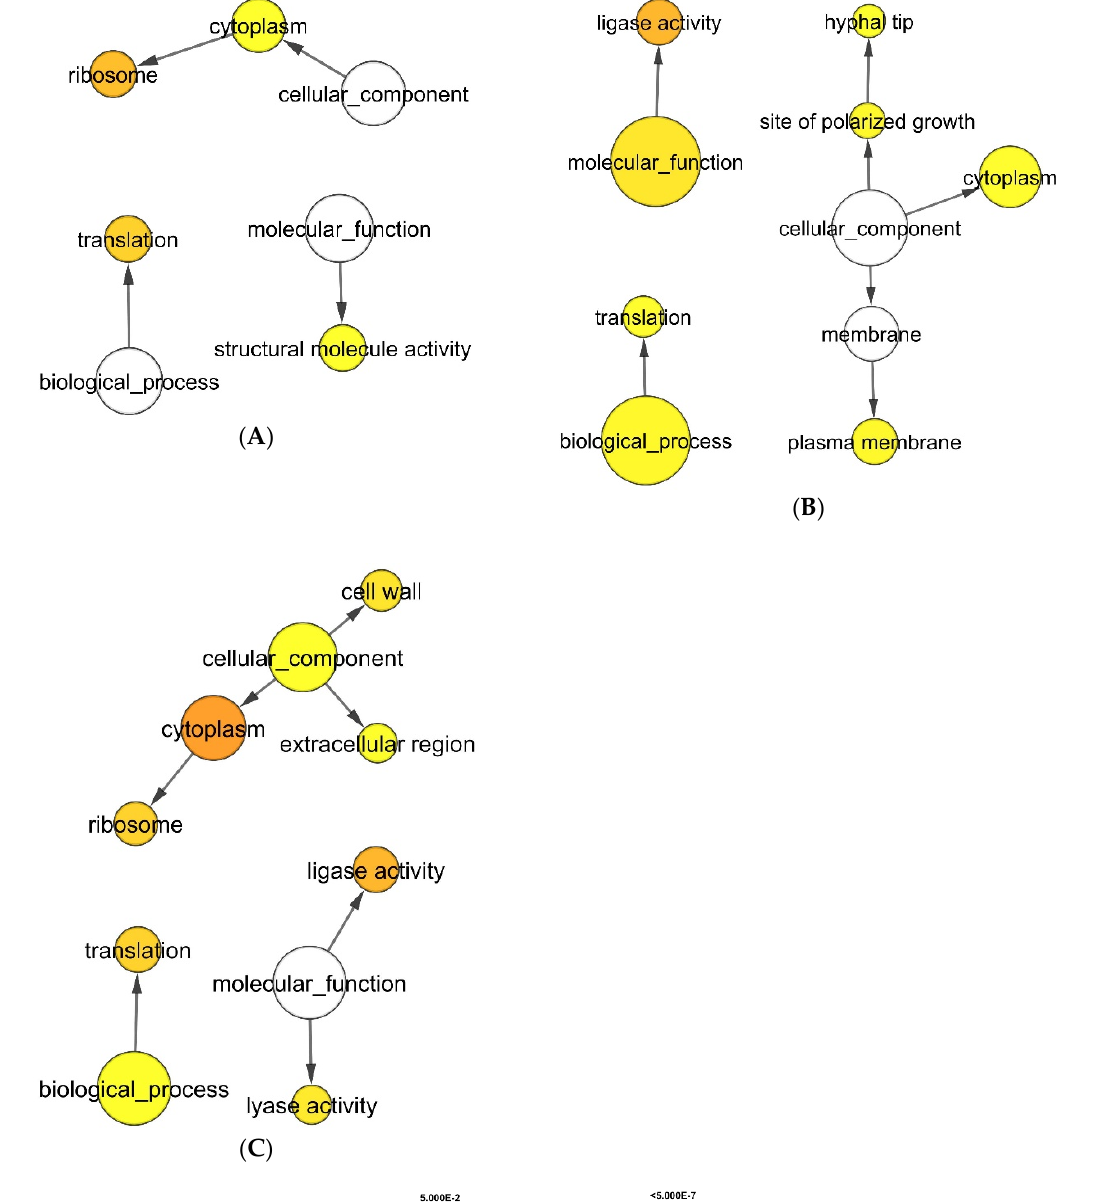
Figure 5. Gene ontology analysis of proteins with higher expression in C. albicans biofilms when exposed to di ff erent groups of bacteria. Proteins extracted from 48 h mature biofilms were sent for label free mass spectrometry analysis. Di ff erential expression analysis was first applied to determined biofilms’ proteins which were higher in each cluster. Subsequent gene ontology analysis illustrated biological processes which were significant higher in the C. albicans under bacterial stimulants: ( A ) Group 1: A. naeslundii , E. faecalis , and P. gingivalis ; ( B ) group 3: S. mutans and S. sanguinis ; ( C ) group 4: S. mitis and S. sobrinus ( p -value < 0.05). The protein expression levels were represented in p -value using di ff erent colors: yellow (least significant) to orange (most significant). The white circles describe the 3 distinct aspects of how gene functions can be described: molecular function, cellular component, and biological process.